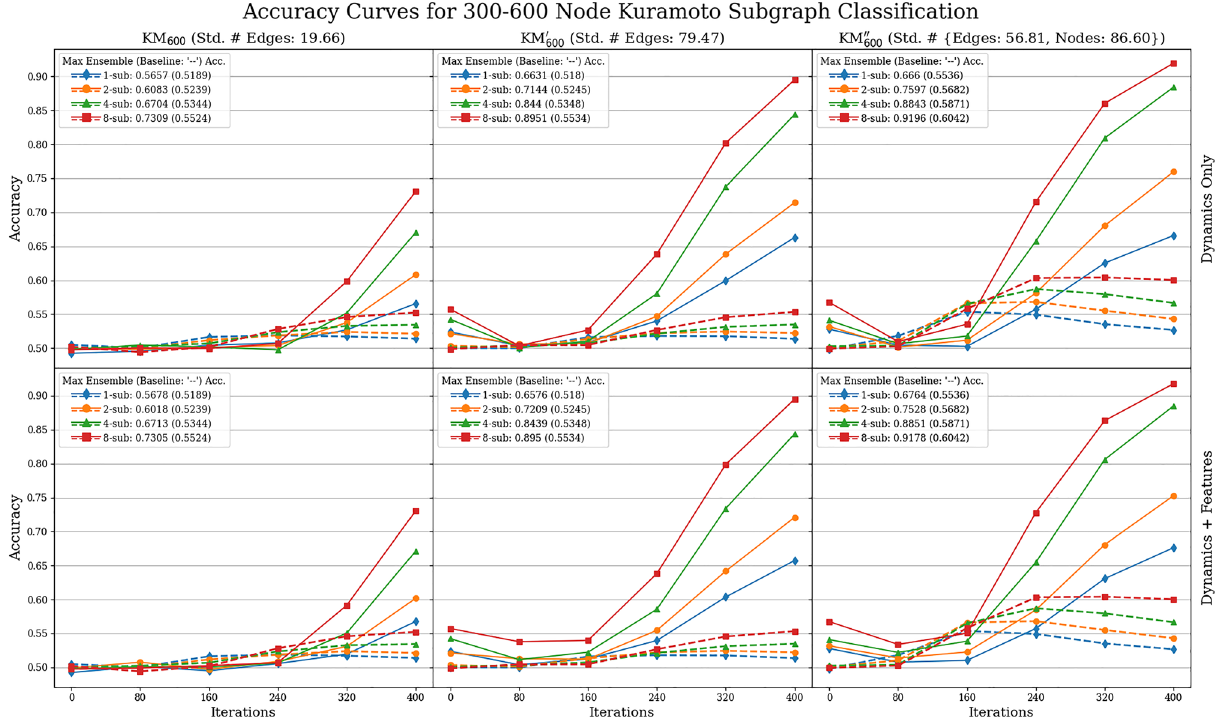
Figure 6. Accuracy curves for predicting synchronization of the Kuramoto model on 600-node graphs from dynamics observed from k ∈ { 1, 2, 4, 8 } subgraphs of 30 nodes. All plots observe the performance of both the ensemble machine learning (solid) and baseline (dashed) accuracies over increasing amounts of training iterations r ∈ { 0, 80, 240, 320, 400 } . The first row shows results using only dynamics whereas the second row includes both the dynamics and graph features. Maximum accuracies for using k subgraphs are given by ‘ k -sub: Acc. (Baseline Acc.)’